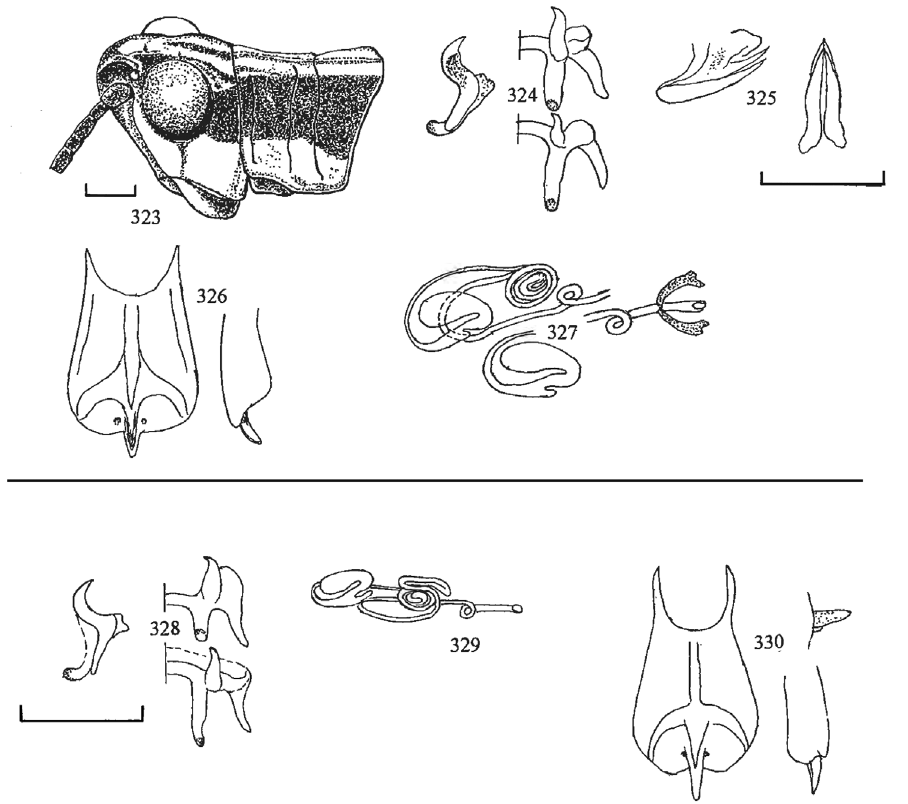
Figs 323–330. Tribe Gymnobothrini. Zacompsa spp. Figs 323–327 . Z. festa festa : 323. Head and pronotum obliquely; 324. Epiphallus dorsally and laterally; 325 . Apical valves of aedeagus; 326 . Female subgenital plate from above and side; 327 . Spermathecal duct and spermatheca. Figs 328–330. Zacompsa pedestris : 328. Epiphallus from above and left side; 329. Female spermathecal duct; 330.